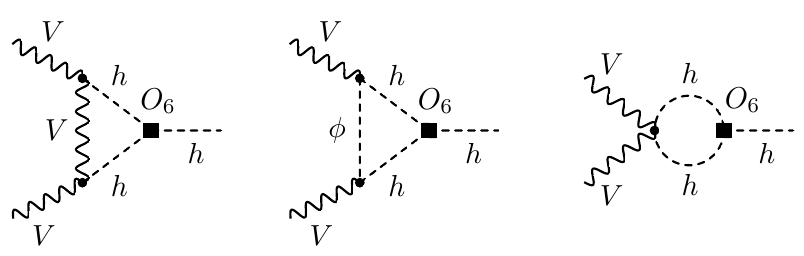
6 that contribute